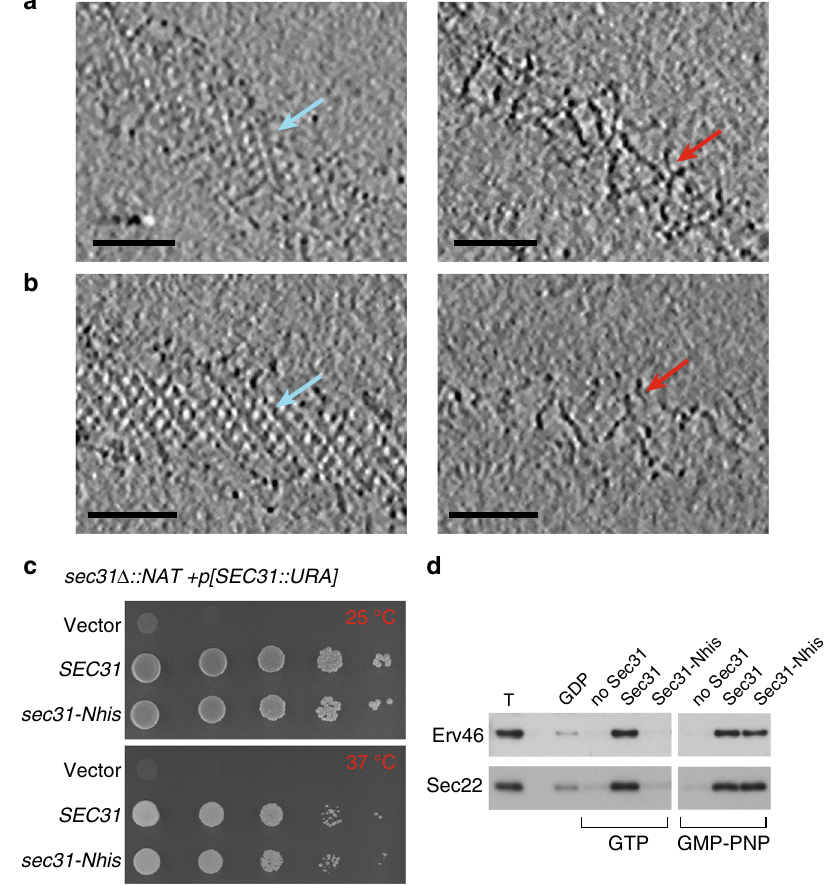
Fig. 1 Inner coat assembly depends on outer coat binding. a XY slices through a tomogram of budding reactions reconstituted with wild-type Sec13 – Sec31 (Sec31 C-terminally his-tagged), showing regular inner coat (blue arrow) and outer coat (red arrow). Scale bars: 50 nm. b XY slices through a tomogram of budding reactions reconstituted with Sec13/31-Nhis, showing regular inner coat (blue arrow) but not outer coat (red arrow). c A yeast strain deleted for SEC31 -bearing plasmids as indicated was tested for viability at 25 and 37 °C, revealing robust growth at both temperatures. d In vitro COPII budding reactions from microsomal membranes were performed using GDP/GTP/GMP-PNP and Sec31/Sec31-Nhis as indicated. T corresponds to 10% of the total donor membranes; remaining lanes correspond to recovered vesicles. Packaging of two cargo proteins, Erv46 and Sec22, was measured by